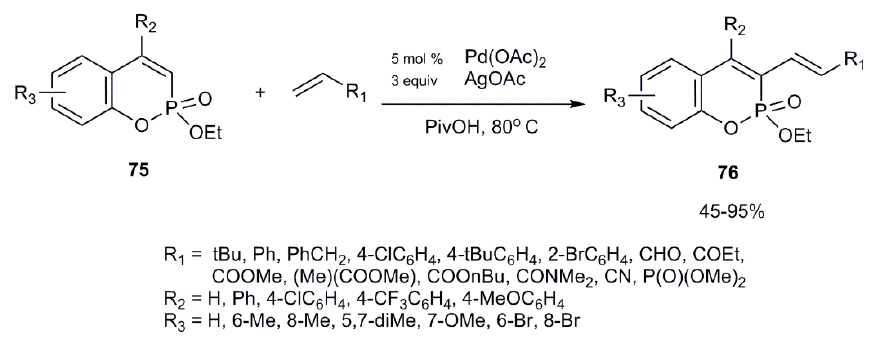
Scheme 48. Palladium-catalyzed Heck reaction.